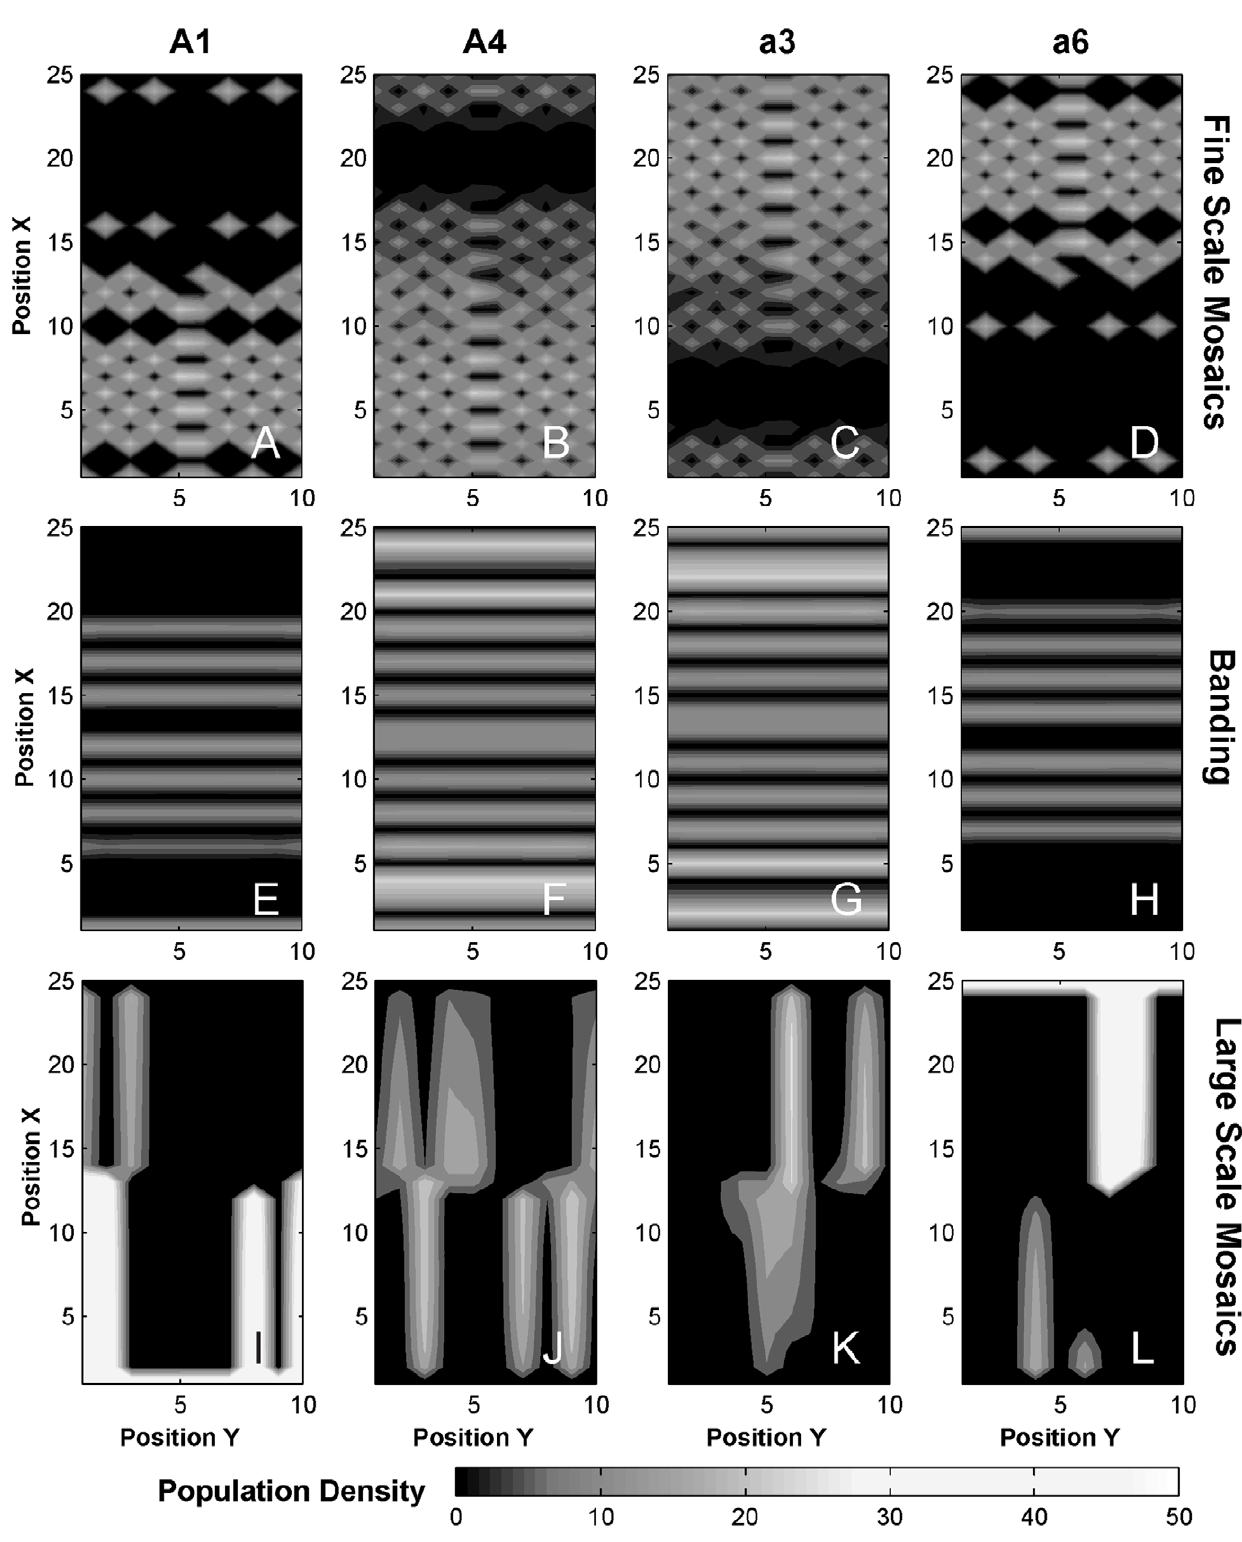
Figure 6. Mosaics and bands. Representative distributions of phenogenotypes A 1, A 3, a 4, and a 6 are shown as contour plots across the grid of patches (x,y) for fine scale mosaics (A–D, Area II, Match), bands (E–H, Area IV, Common), and large scale mosaics (I–L, Area III, Match). For the large scale mosaics, the initial densities for A 1 ( x=1 ) and a 6 ( x=25 ) was drawn from a Gaussian distribution of mean 10 and standard deviation 2. Diffusion and paternal transmission were set to 0.